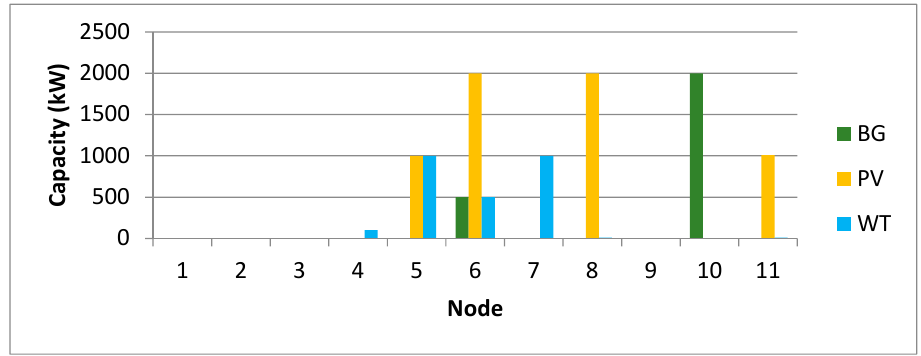
Figure A3. Capacity structure for 50% share of energy from RES in total demand with sizing and allocation of RES only.